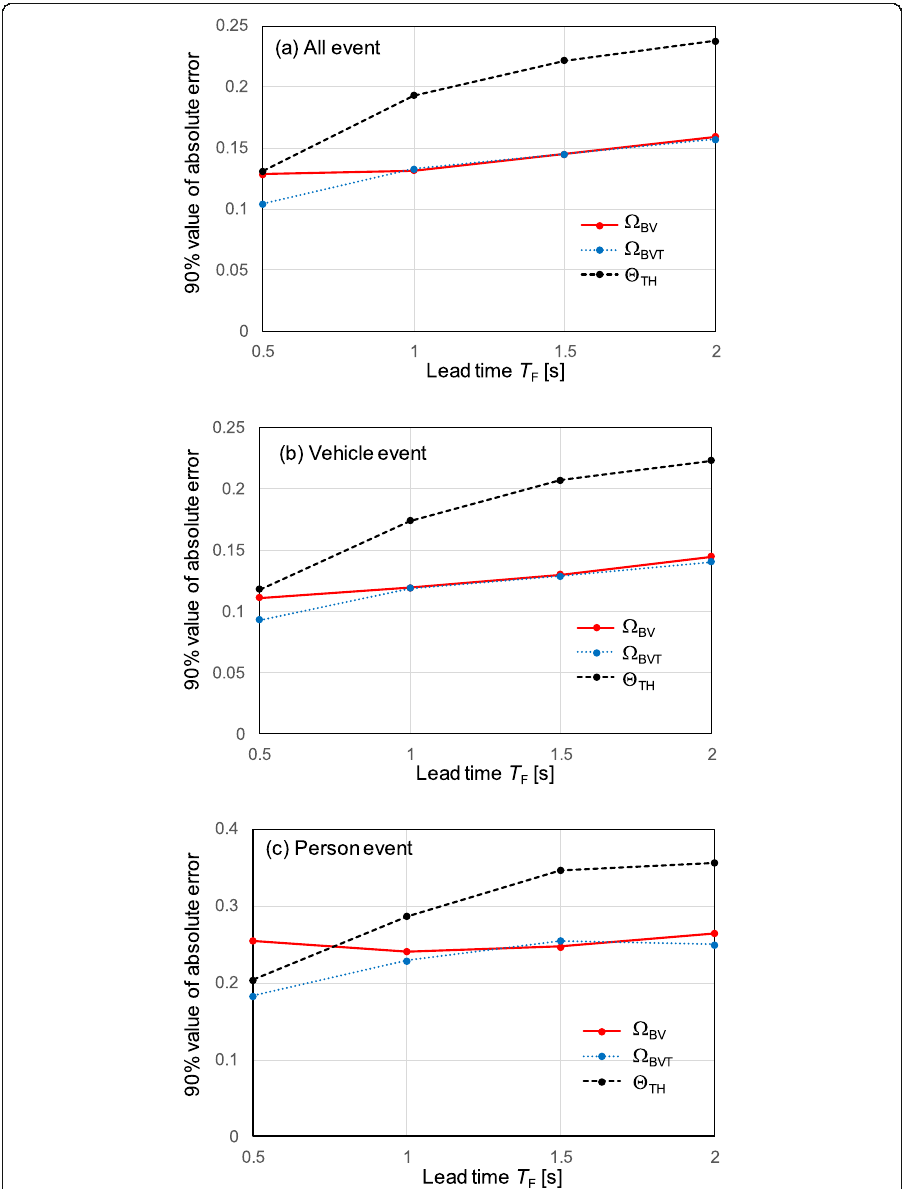
Fig. 13 The 90% values of CDFs of the absolute prediction error for lead time T F . a All-transit event, b vehicle event, and c person